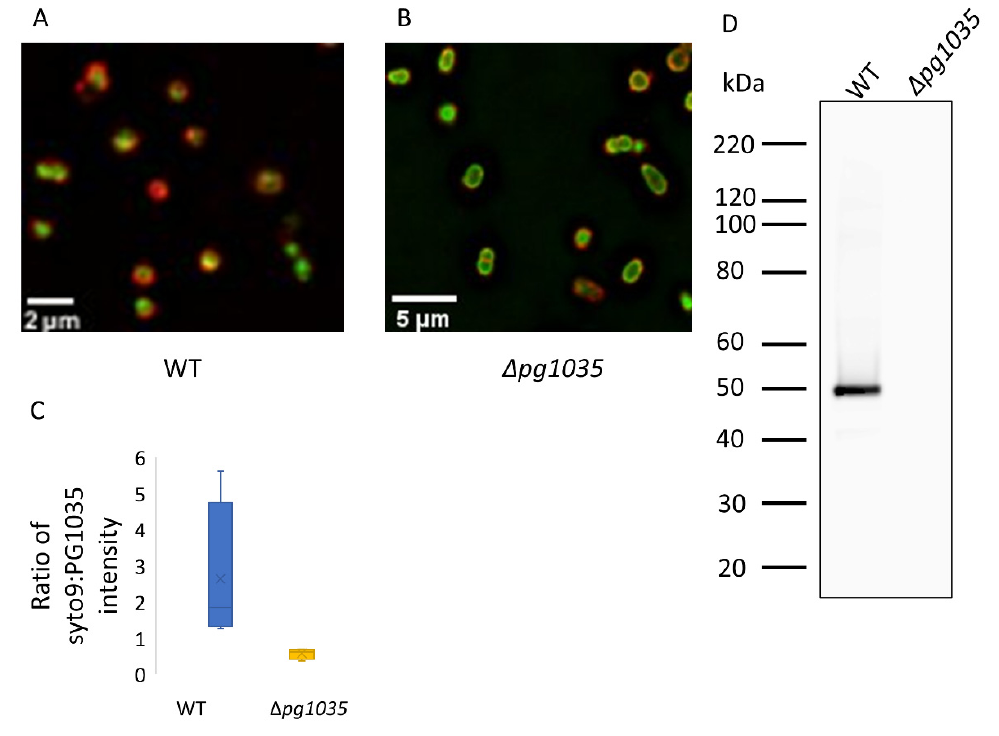
Figure 5. PG1035 is localised on the cell surface and is not modified by A-LPS . ( A ) WT and ( B ) Δ pg1035 mutant cells were immune stained with anti-PG1035 antibodies, followed by goat anti-rabbit secondary antibodies conjugated to Alexa-647 (red) and syto 9 (green). ( C ) Box plot of the fluorescent intensity signal measured by ImageJ. ( D ) Proteins in the whole cell lysates of the WT and Δ pg1035 deletion mutant were electrophoresed on an SDS-PAGE gel. The proteins were transferred onto a membrane and probed with PG1035 antibodies.